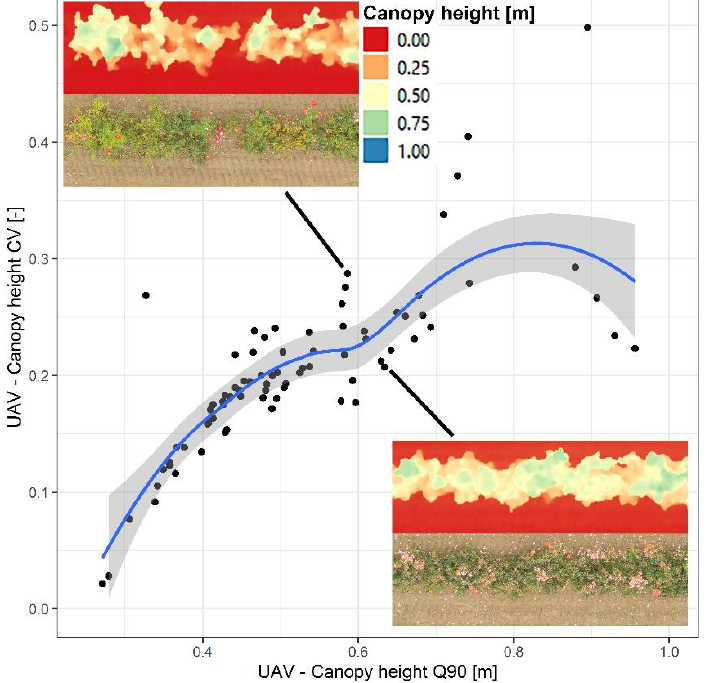
Figure 9. Variations present in the rose trial related to canopy height (UAV_HQ90) and uniformity (UAV_Hcv) with a top view image and a height image based on the CHM for two genotypes.